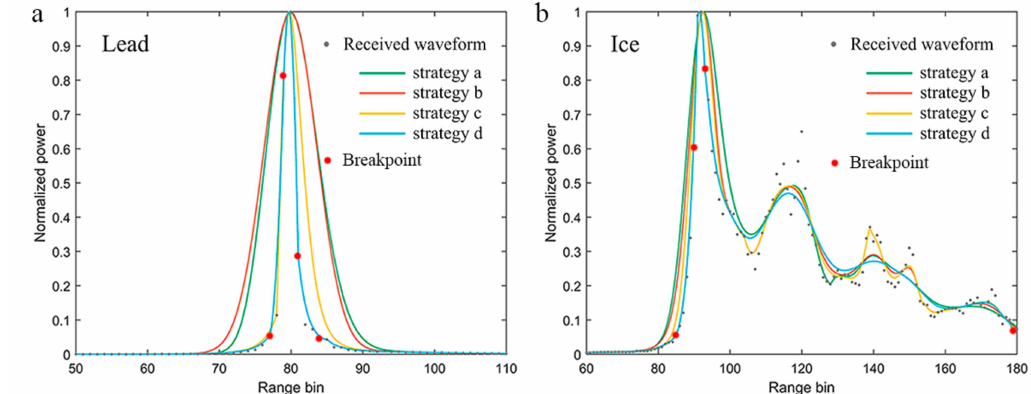
Figure 2. Comparisons of fitting performances using segment strategy a, strategy b, strategy c, and strategy d for typical lead ( a ) and ice ( b ) waveforms. Red points are the breakpoints for strategy